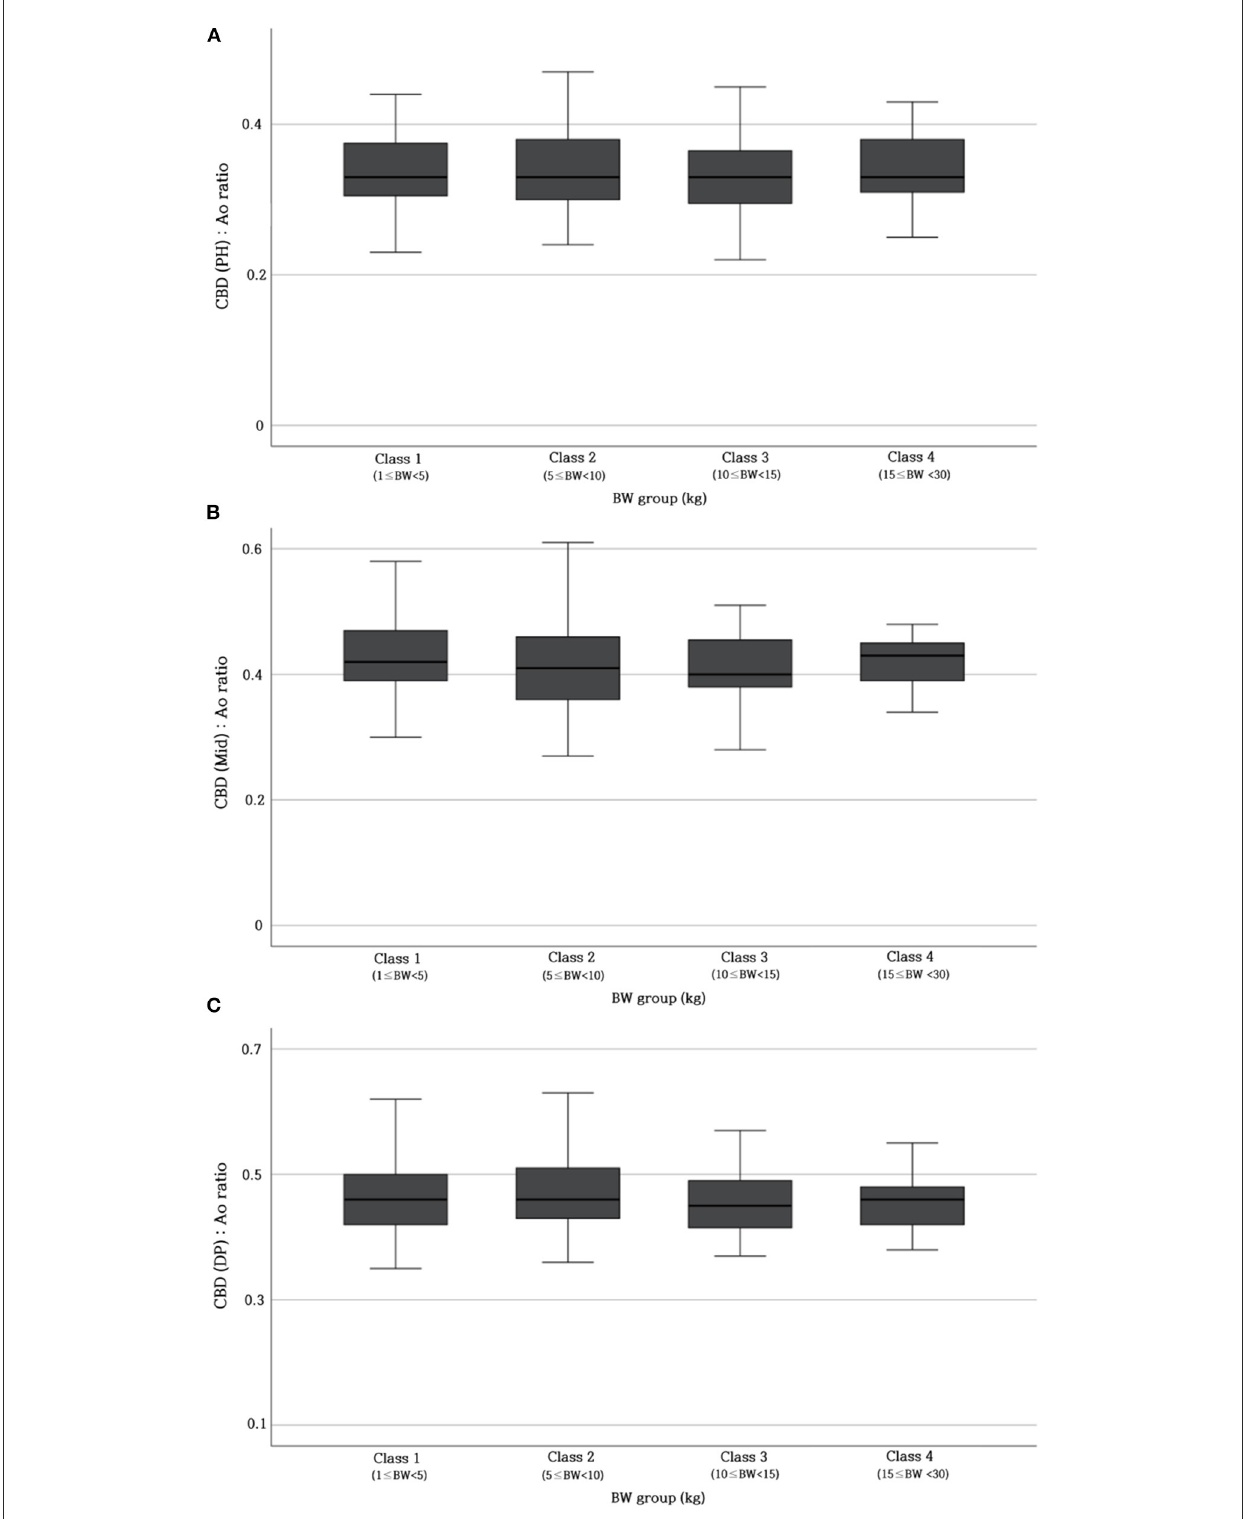
FIGURE4 Differences in CBD: Ao ratio at PH level (A) , Mid-level (B) , and DP level (C) between different BW groups. No significant differences ( p > 0.05) are found in the CBD: Ao ratio between the BW groups. Ao, abdominal aorta; BW, body weight; CBD, common bile duct; DP, duodenal papilla; Mid, mid-portion; PH, porta